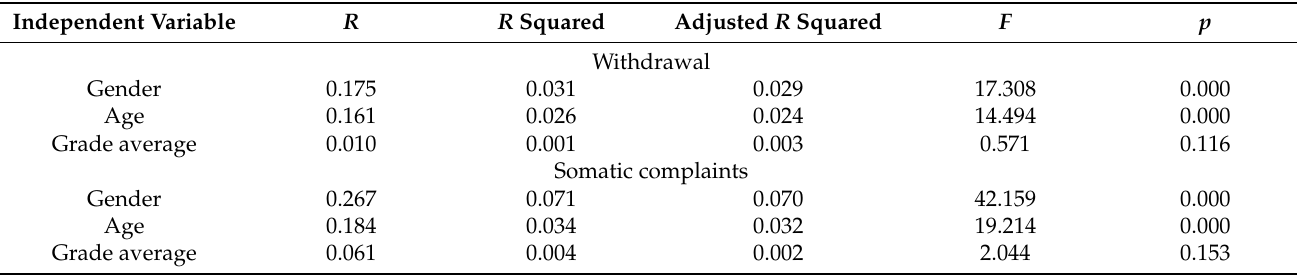
Table 6. Regression analysis of the dependent variables—individual problem behavior